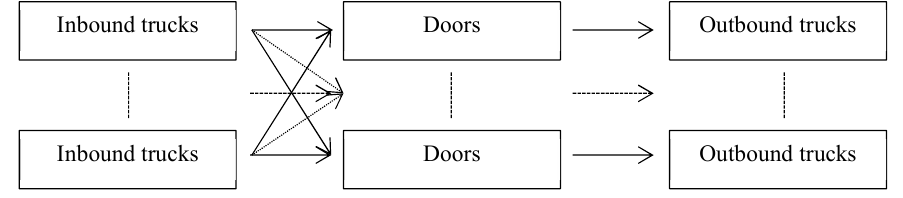
Fig. 1. Assignment of inbound and outbound trucks to